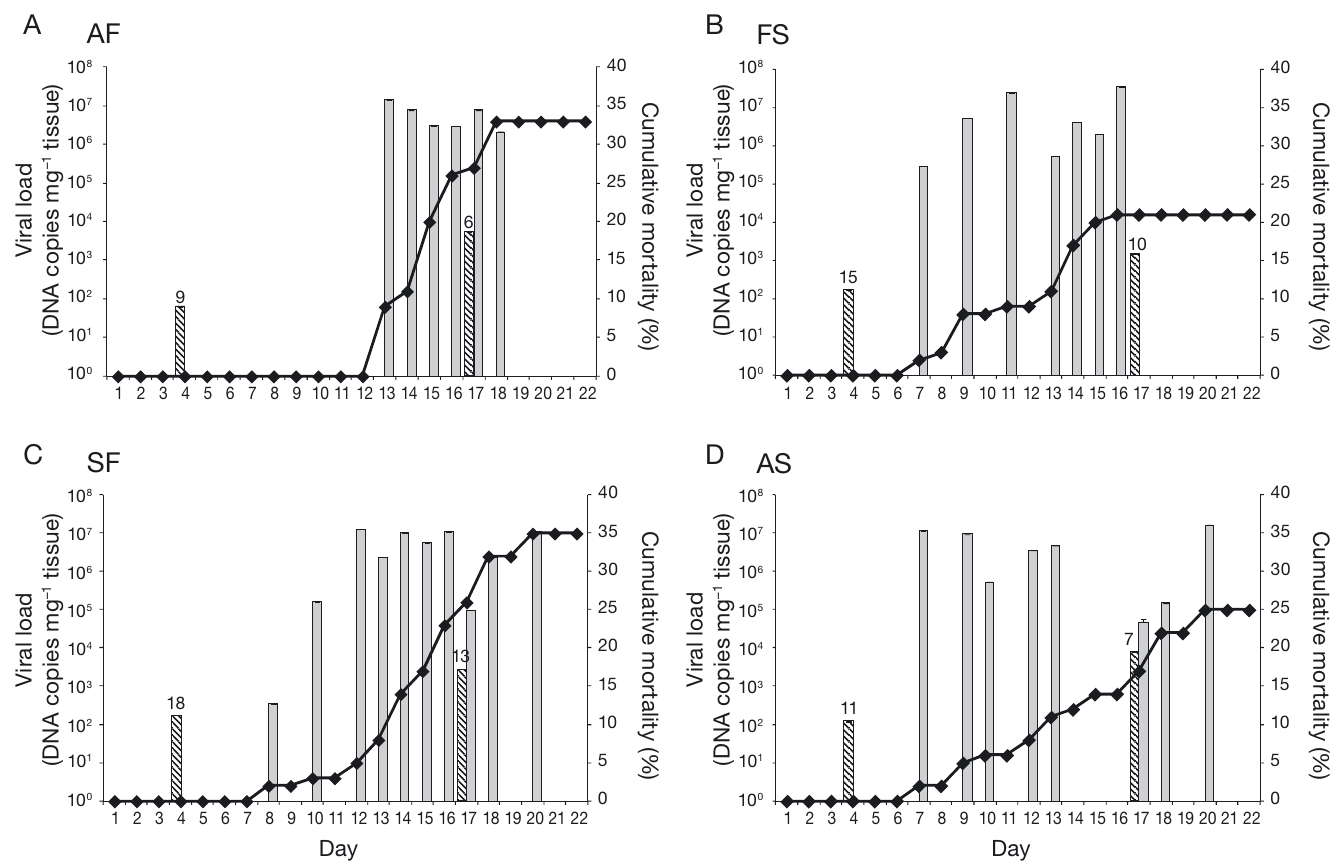
Fig. 2. Cumulative mortality (%), adjusted for the effects of daily random sampling (line), mean (geometric) viral load (copies mg –1 of tissue, ± SD) (striped bar) and dead cohabited (solid grey bar) oysters (all that died that day), and number of live in- fected oysters out of 24 (number over bars) for the live sampled oysters, for each of the 4 treatment groups: (A) always fed (AF), (B) fed then starved (FS), (C) starved then fed (SF), and (D) always starved (AS). SD is on the y -axis and where it is less than the viral load it is not visible above the